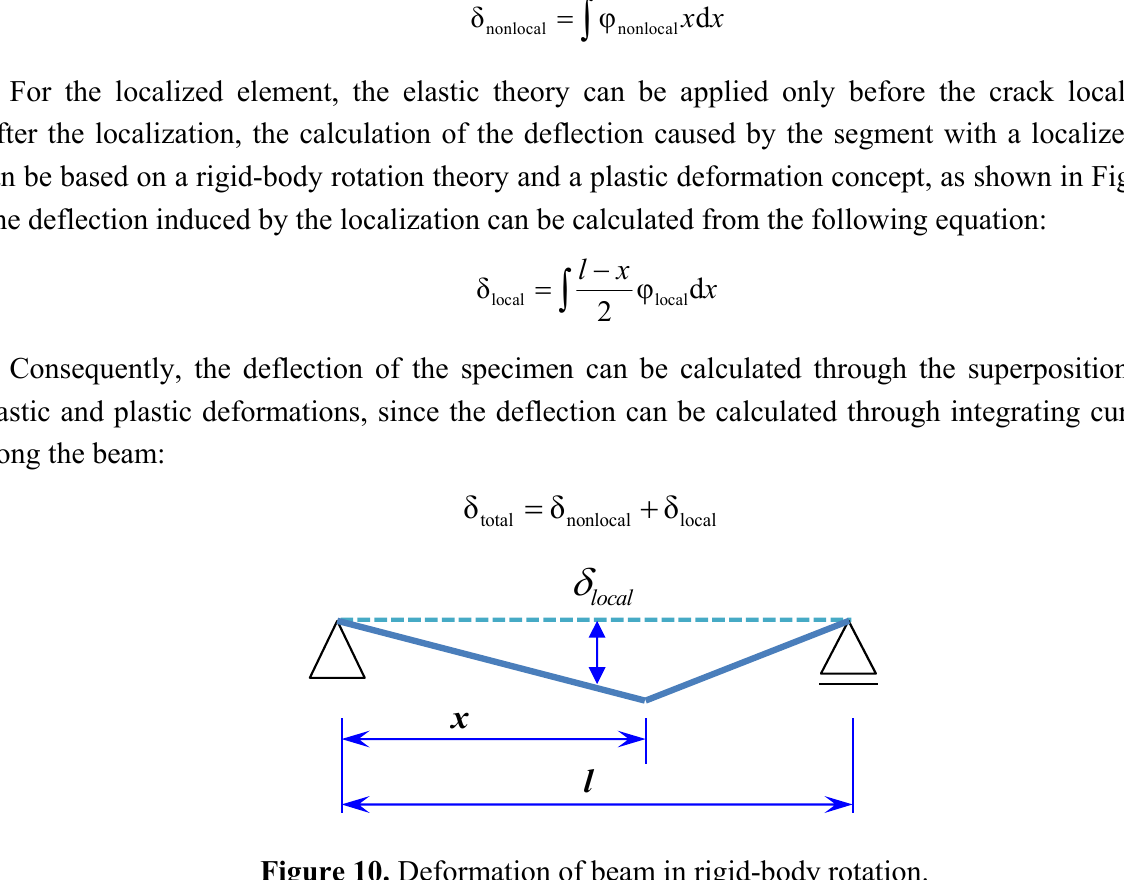
Figure 10. Deformation of beam in rigid-body